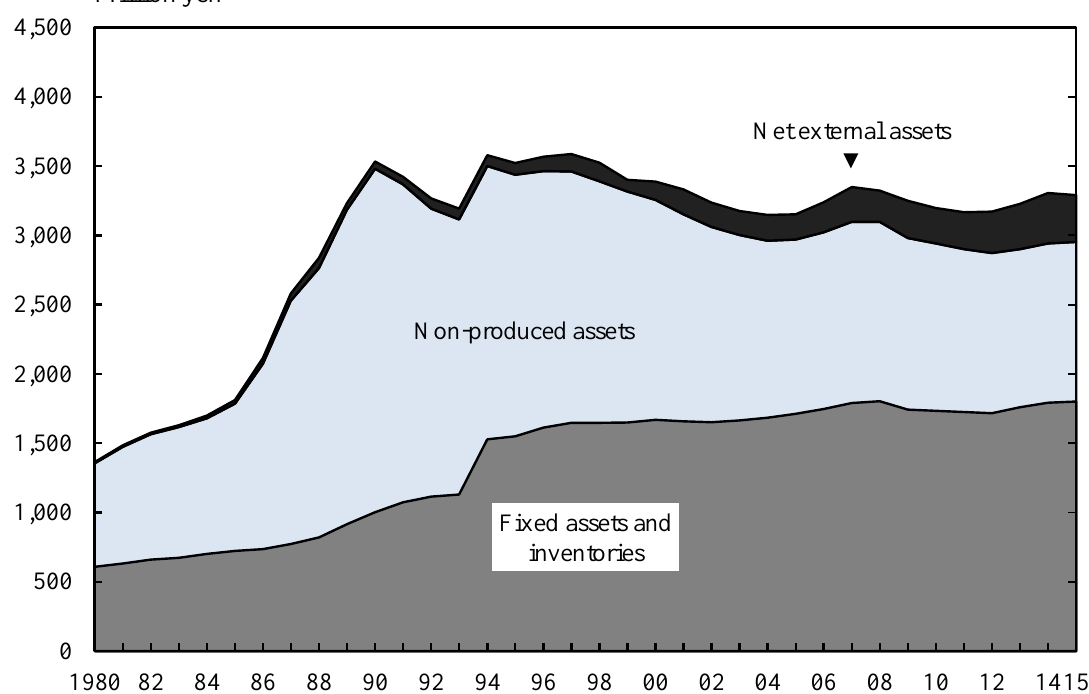
Figure 3.2 National Wealth 1) Trillion